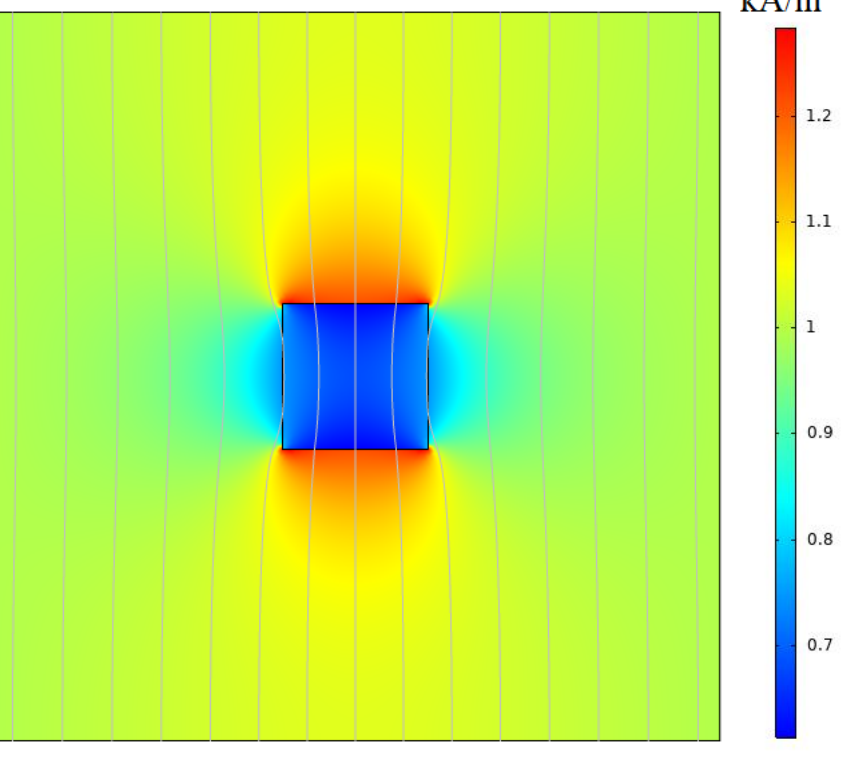
Figure 8. Magnetization